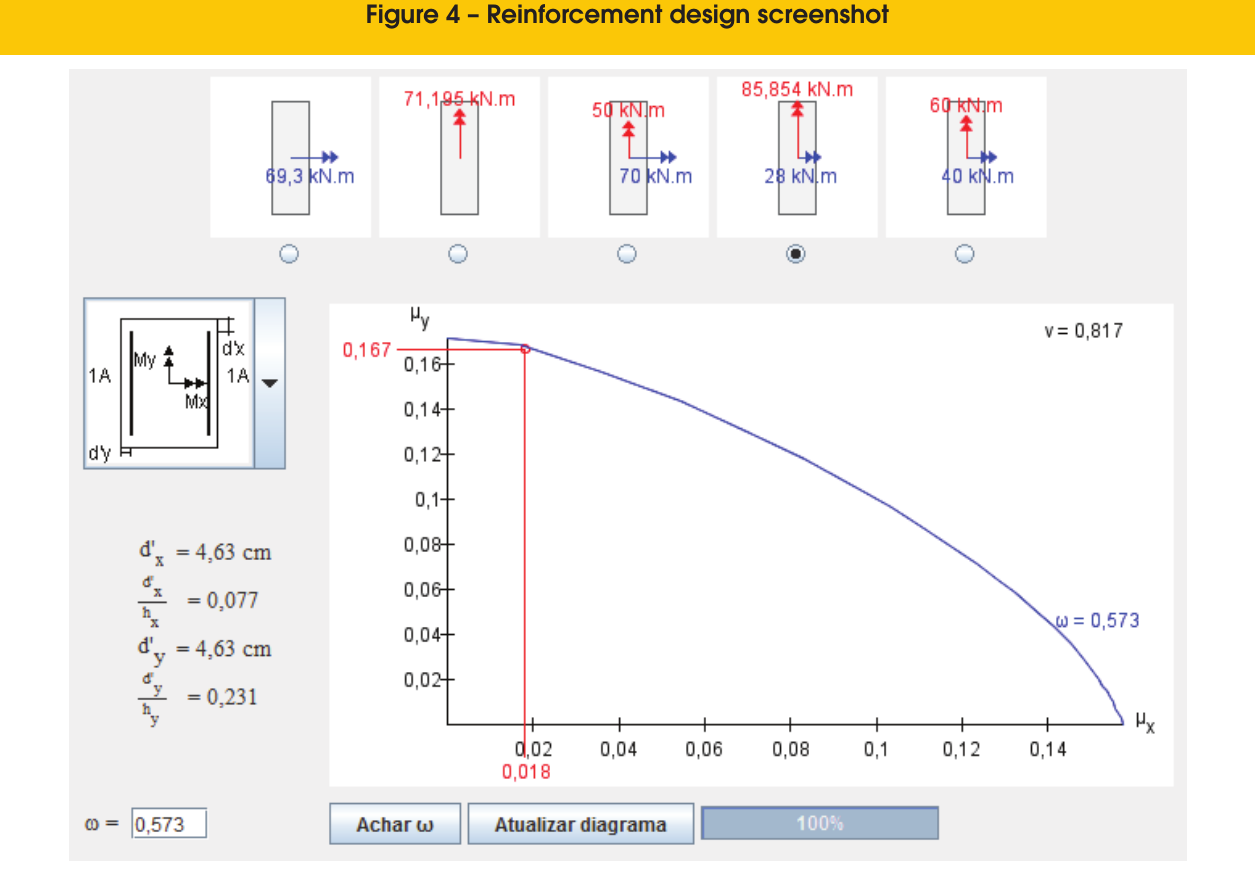
Figure 4 – Reinforcement design